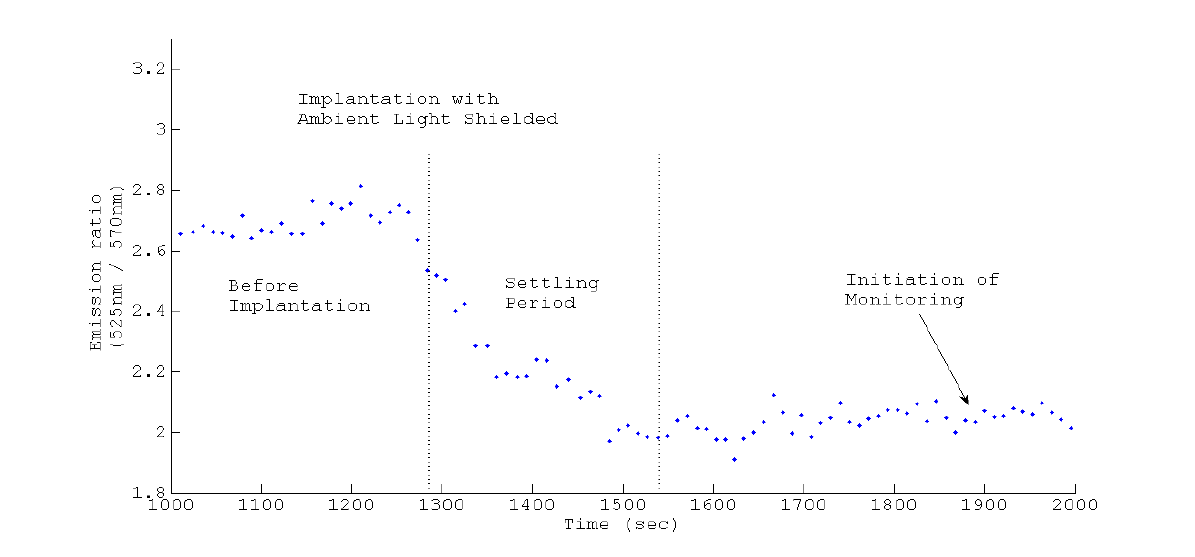
Figure 4. Fluorescence emission ratio change trend before and after